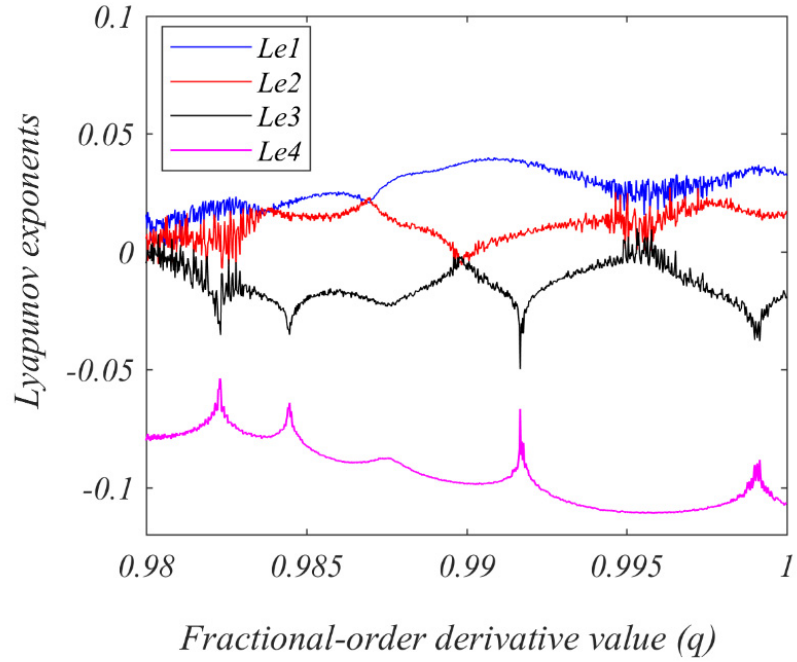
Figure 12. The system (17) Lyapunov exponents in contradiction to varying the system fractional- order derivative value ( q ).